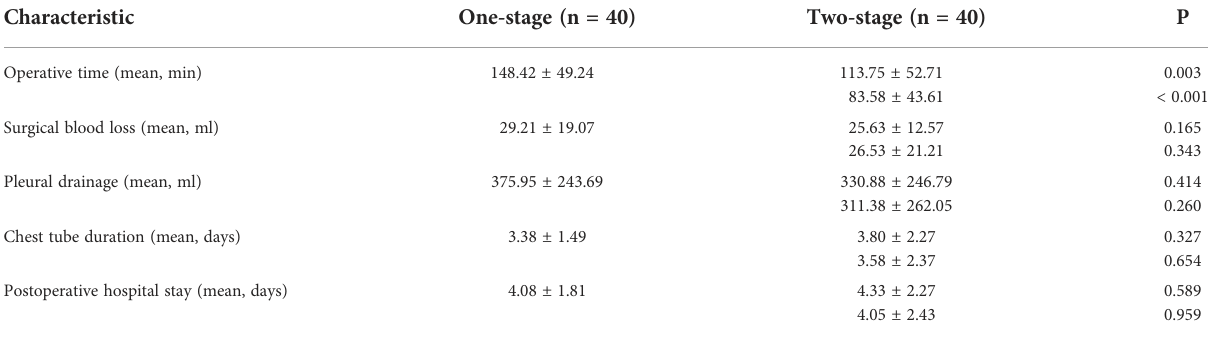
TABLE 3 Comparison of perioperative clinical data of the two groups.